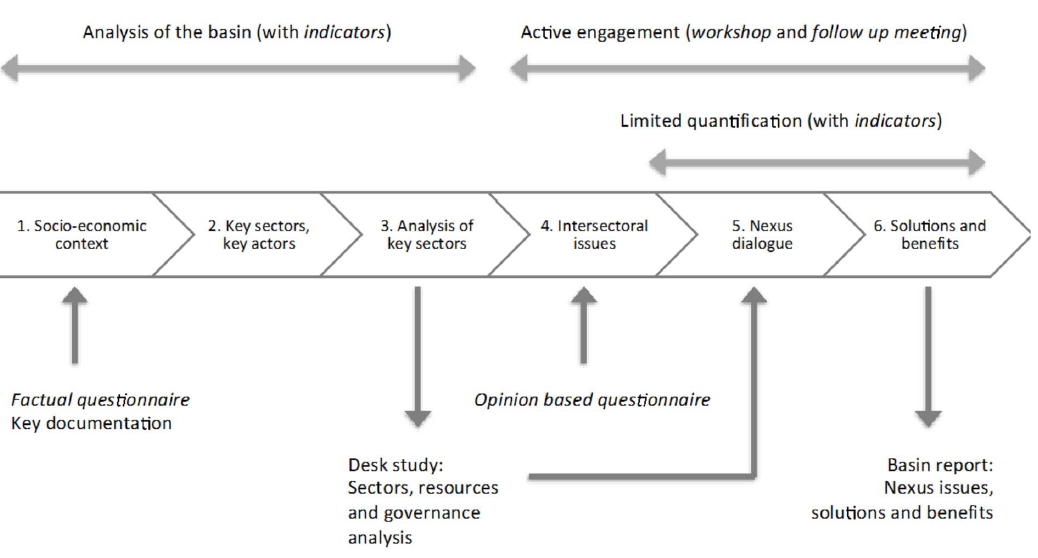
Figure 1. Schematic of the six steps with inputs and